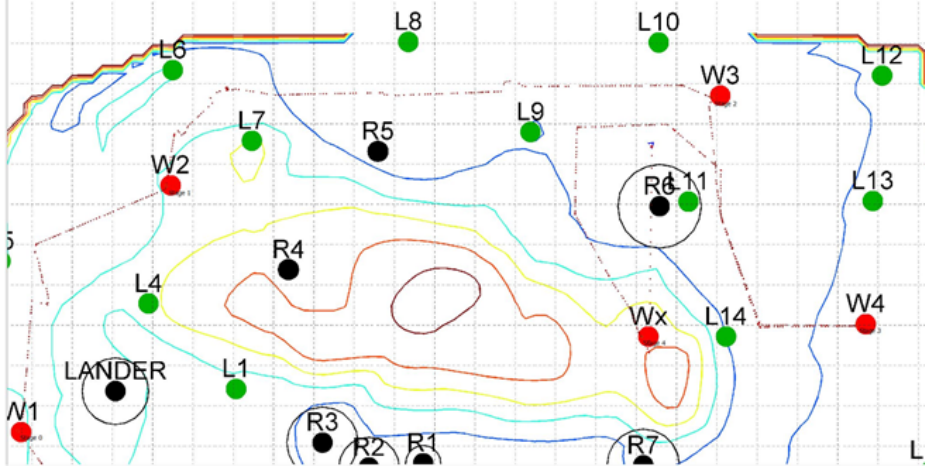
Figure 14. Software screenshot presenting the real position of the robot in test track. The places with obstacles were marked in black (letter R). The robot’s position on the track was marked on the map with a red dotted line. The side of the map grid shows a resolution of 1m. In Figure 15, the arrows show the corrections made during the driving. The black arrow indicates the correction made after detecting the markers number L4 and L5, while the red arrows indicate where the control system made corrections after detecting the L6 and L7 markers. As mentioned in [21], the recognition range of the system was limited to about 6 m, therefore corrections are calculated near the markers. During the main drive at the competition, the vehicle reached the checkpoints with the following